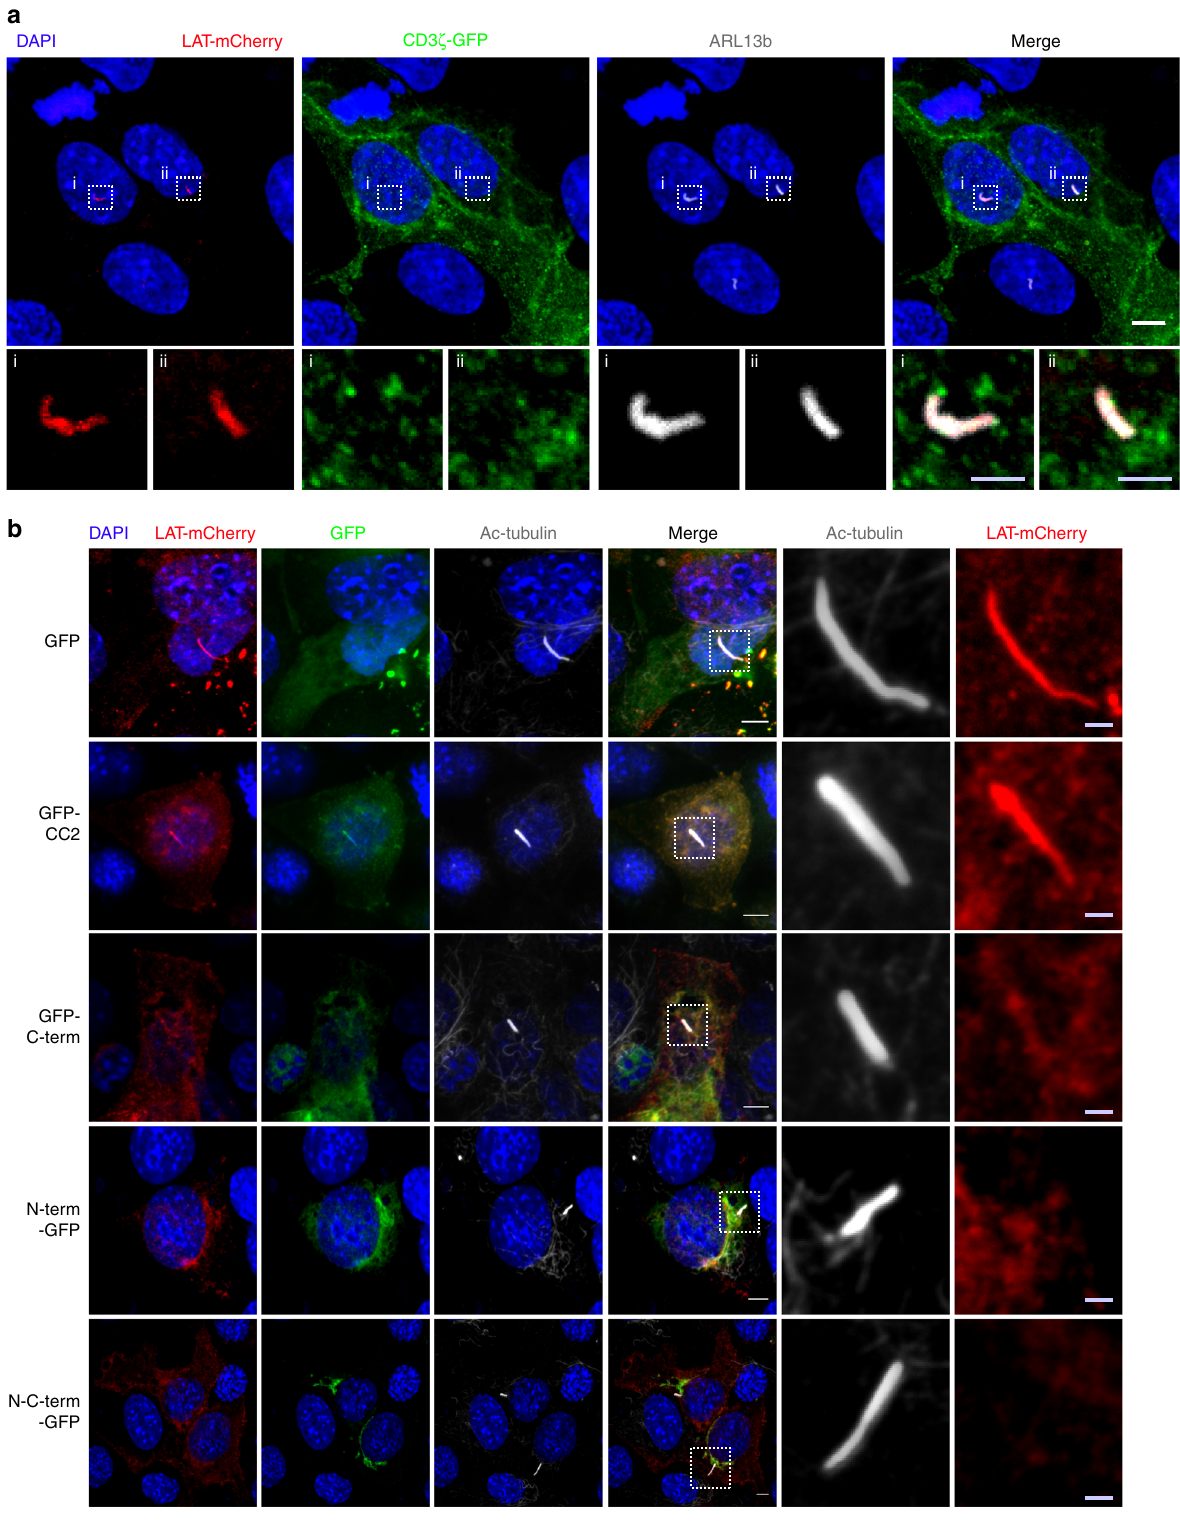
Fig. 8 Speci fi c recruitment of LAT to the primary cilium depends on GMAP210 tethering activity. a Confocal images showing the localization of ARL13b (gray) and LAT-mCherry (red) or CD3 ζ -GFP (green) in ciliated mIMCD-3 epithelial cells. Staining of the nucleus by DAPI in blue. White squares indicate the magni fi ed regions presented underneath that shows the primary cilia. White scale bars: 5 μ m, gray scale bars: 1.5 μ m. b Confocal images showing the relative localization of LAT-mCherry (red) and acetylated-tubulin (gray), in mIMCD-3 cells co-expressing GFP alone, GMAP210-GFP, or different domains coupled to GFP. White squares indicate the magni fi ed regions presented on the right that shows the primary cilia. White scale bars: 5 μ m, gray scale bars: 1.5 μ m. Images representative of two independent preparations in a and one preparation in